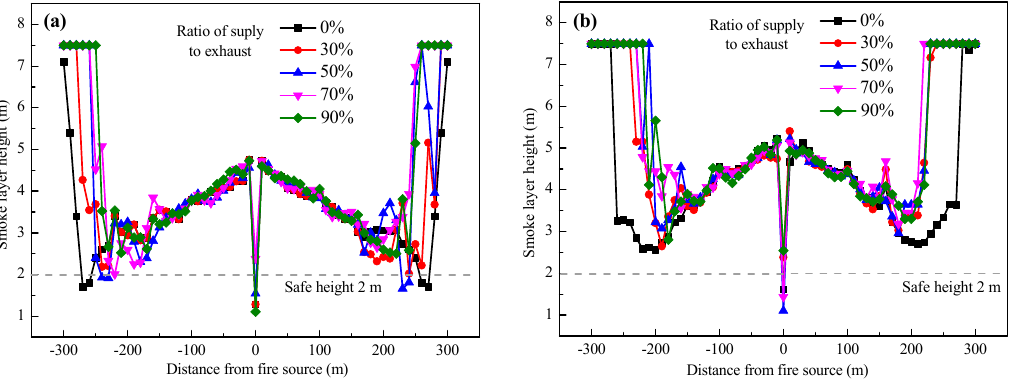
Figure 4. Smoke layer height under different air supply volume: ( a ) sidewall exhaust; ( b ) top exhaust.